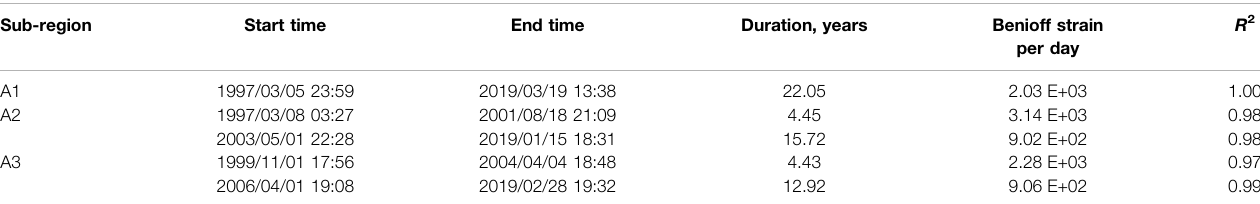
TABLE 4 | The cumulative Benioff strain release Ʃ (t) function linear fi t intervals for three FVG sub-regions. Sub-region Start